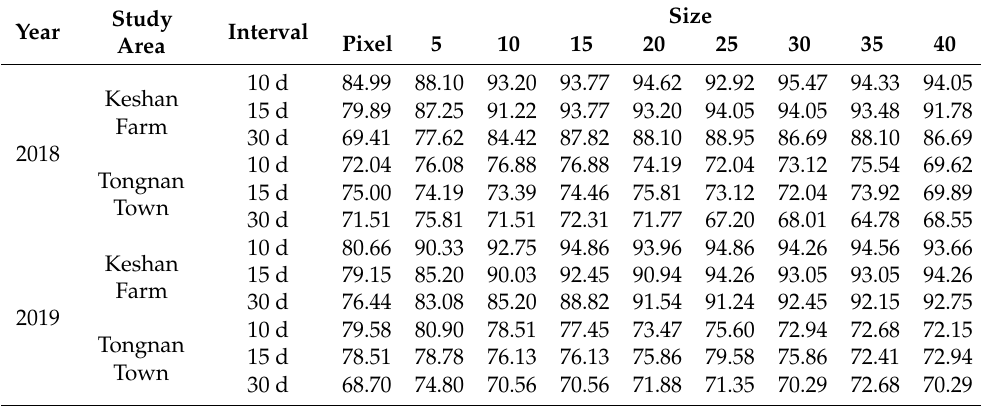
Table 3. The overall accuracies obtained using different classification schemes in different study areas.